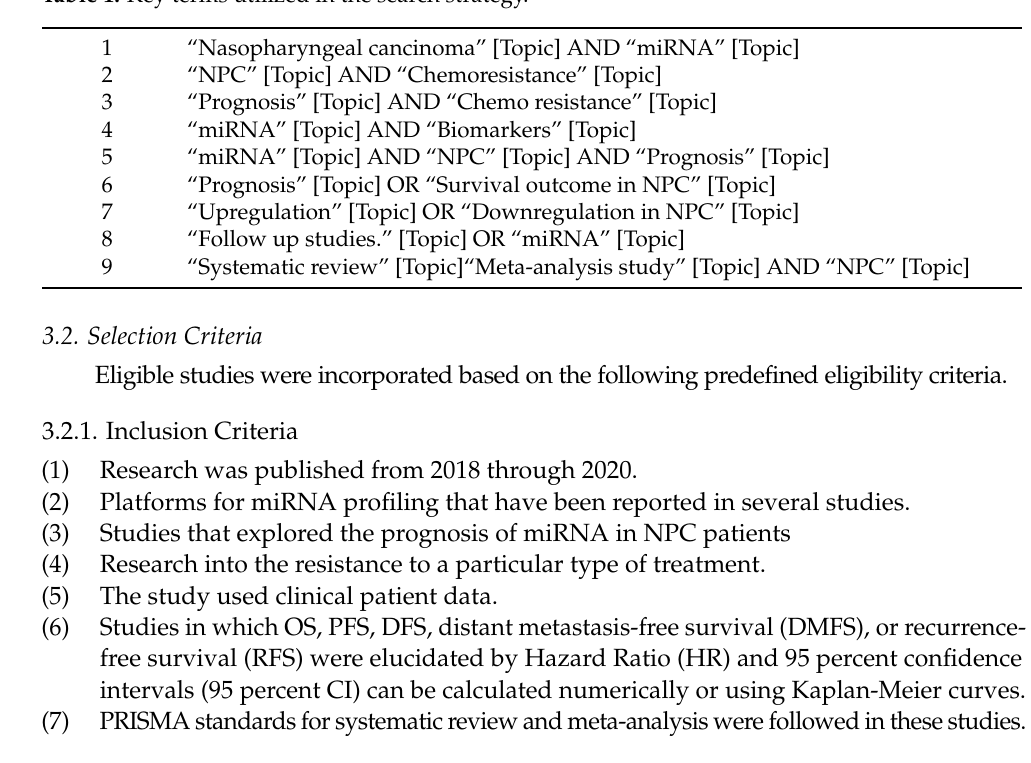
Table 1. Key terms utilized in the search